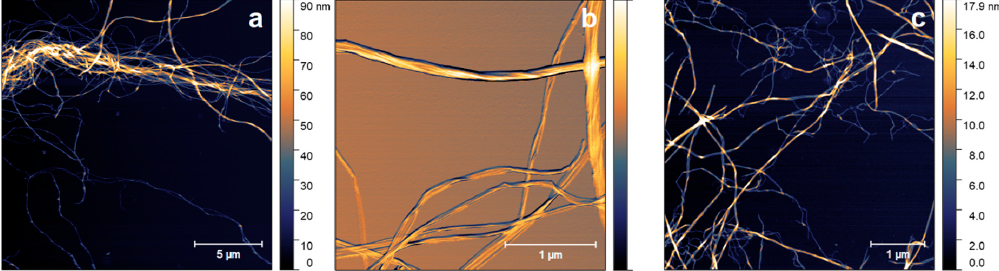
Figure 5. AFM pictures of bacterial cellulose subjected to TEMPO-mediated oxidation in aqueous near-neutral- (pH 6.8; a , b ) and alkaline conditions ( c ) at different magnification.